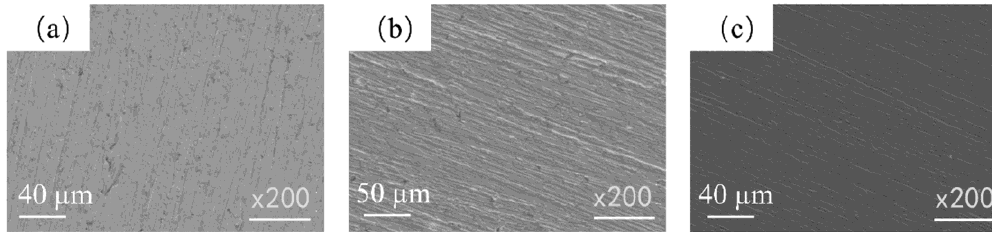
Figure 2. Surface topography of ( a ) Ta substrate, ( b ) TD film and ( c ) TTTD film.